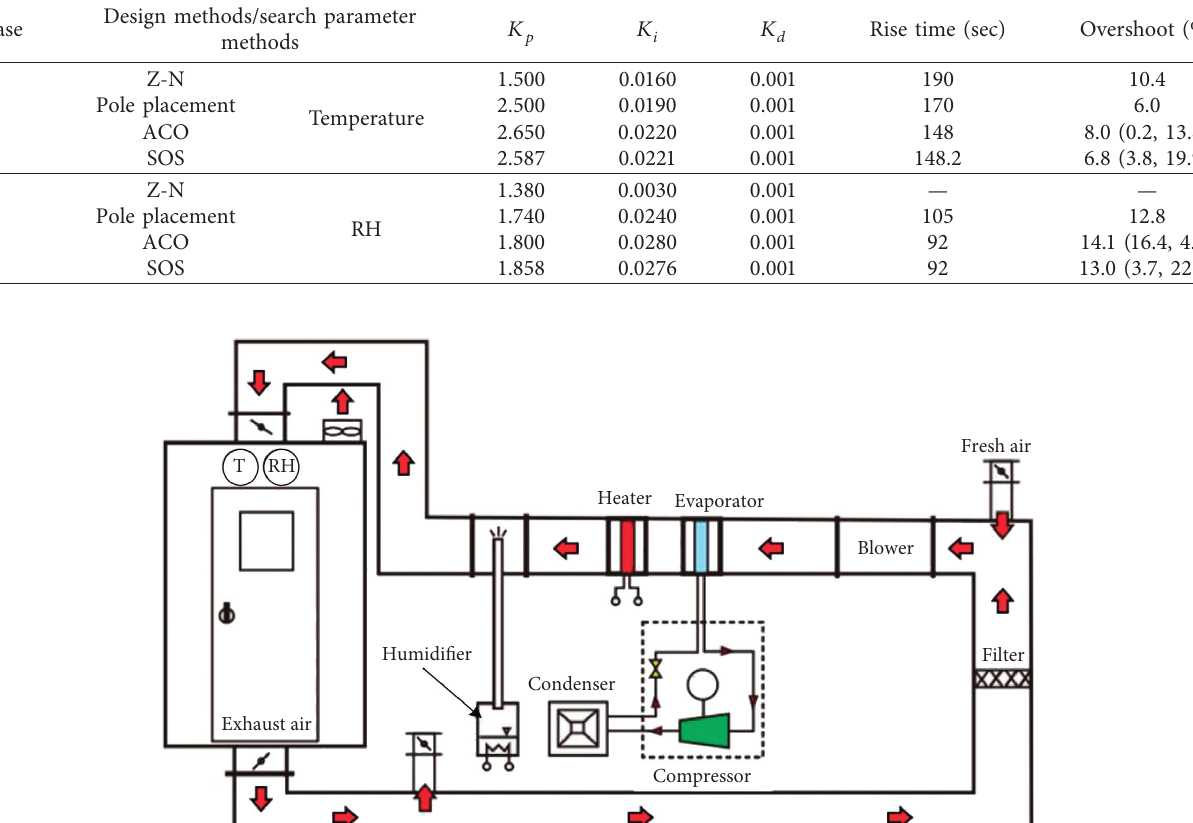
Table 2: Parameter gain of PID controller using various design methods.